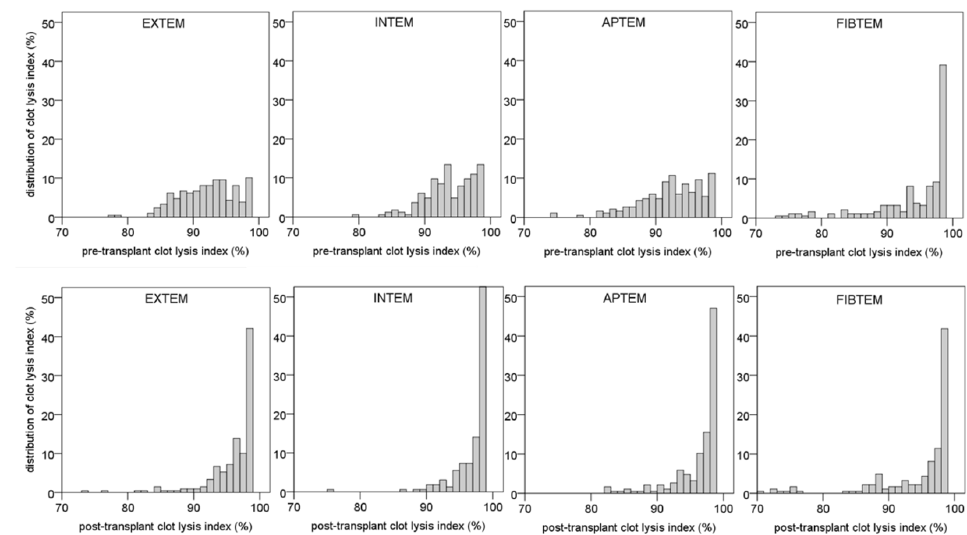
Figure 1. Distribution of clot lysis index obtained with ROTEM™ at the beginning (upper row) and at the end of liver transplantation (lower row) using four different assays (EXTEM: tissue factor activation, INTEM: ellagic acid activation; APTEM, tissue factor activation and fibrinolysis inhibition with aprotinin; FIBTEM: tissue factor activation and platelet clot retraction inhibition with cytochalasin D).